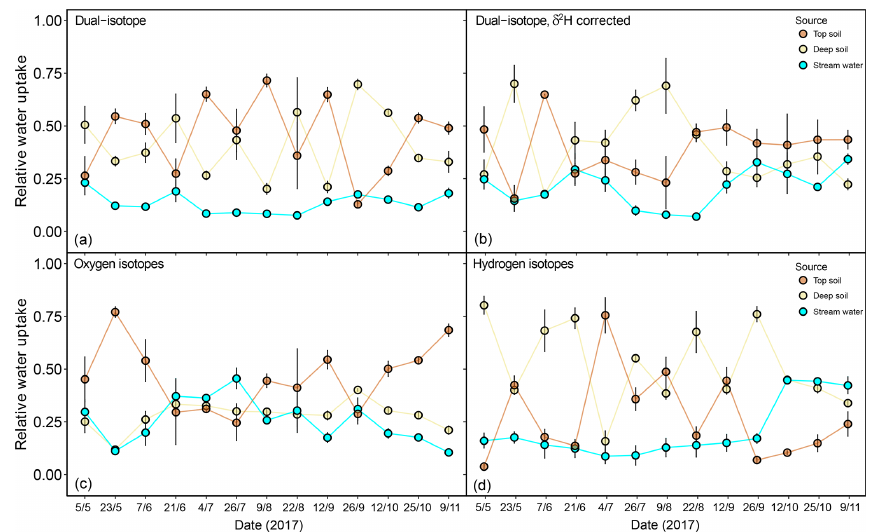
Figure 7. Relative water uptake from each of the plant water sources considered: topsoil, deep soil and stream water (indistinguishable with groundwater), as estimated with MixSIAR for the dominant trees of F. sylvatica . The input data are different for each of the four panels: (a) uncorrected δ 2 H and δ 18 O, (b) δ 2 H (corrected for SW-excess) and δ 18 O, (c) only δ 18 O and (d) only δ 2 H. The error bars represent standard deviations ( N = 3). Table 1. Output of the generalized linear mixed models computed with the source contributions estimated with different input data and environmental independent variables. Dual implies the use of both water isotopes. Individual models are run per each plant water source and input data type. For each model effect, the β estimate (standardized correlation coefficient) is shown. Marginal R 2 corresponds to the variance in source contribution explained by the model independent variables. Significant effects are highlighted in bold and with asterisks (* P < 0 . 05, ** P < 0 . 01, *** P < 0 . 001). Input data Source Rainfall (5d VPD (5d Top soil Deep